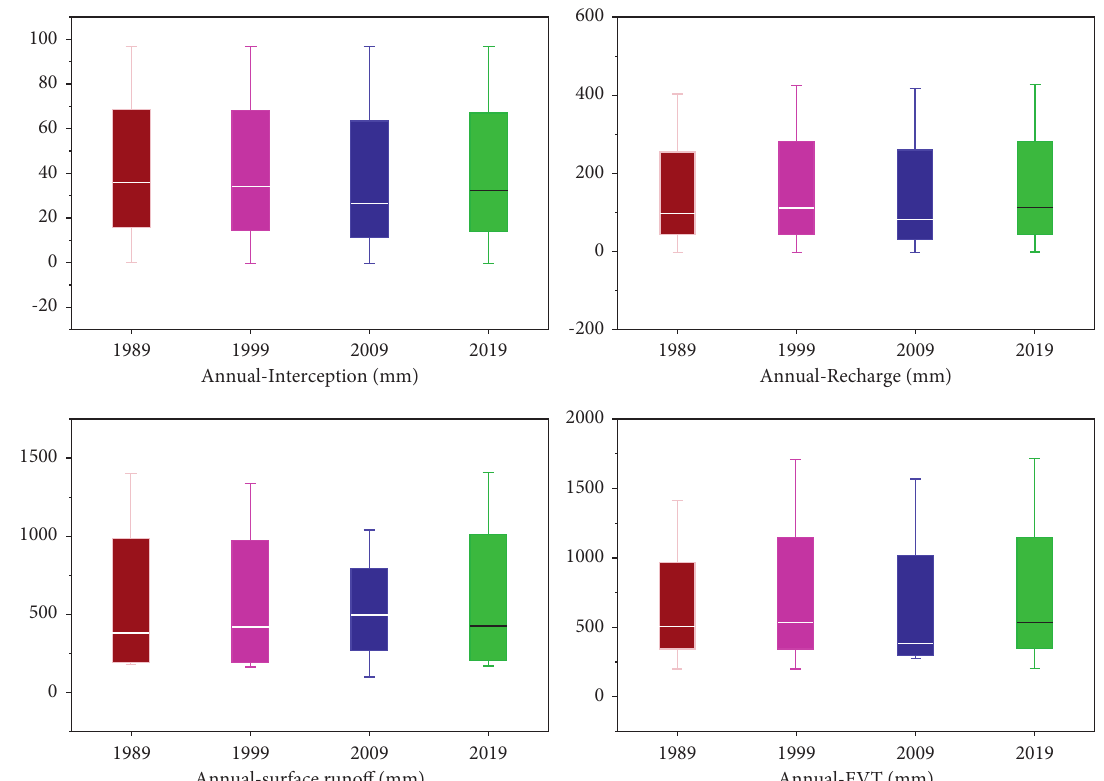
Figure 9: Long-term annual WetSpass-M simulated water balance components of the Bilate basin for LULC (1989, 1999, 2009, and 2019).